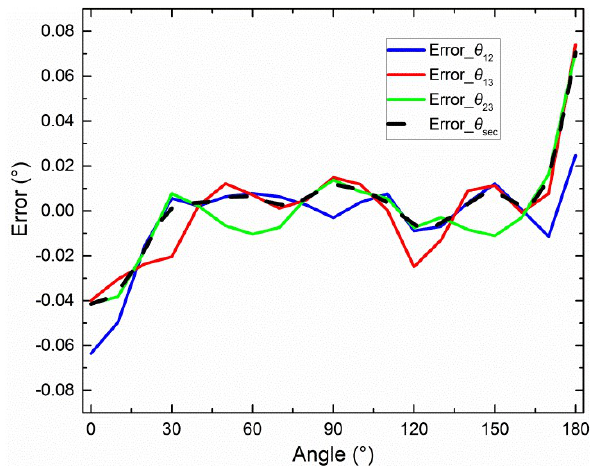
Figure 16. Error curves when only the section algorithm is used.